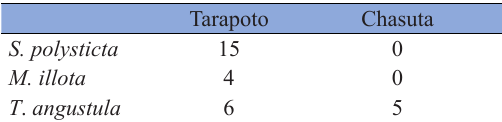
stored at a temperature of 4 °C. In the apiary of Chasuta were present only beehives of the species Tetragonisca angustula. Table 1. Number of honey samples collected by apiary.